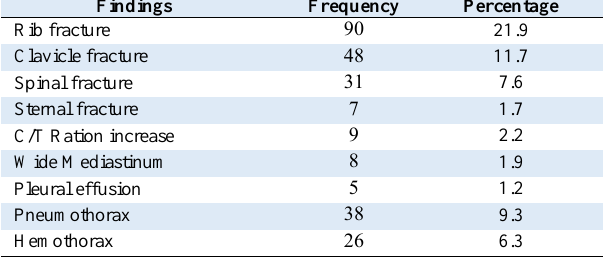
Table 2. Chest CT findings among traumatic travelers